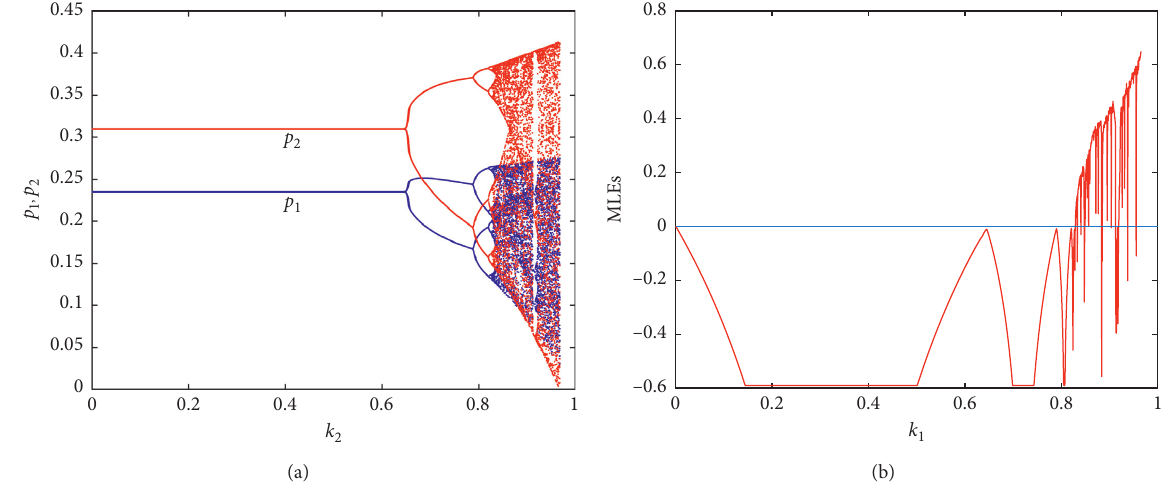
Figure 5: Bifurcation diagram and MLEs for system (38) with respect to parameter k